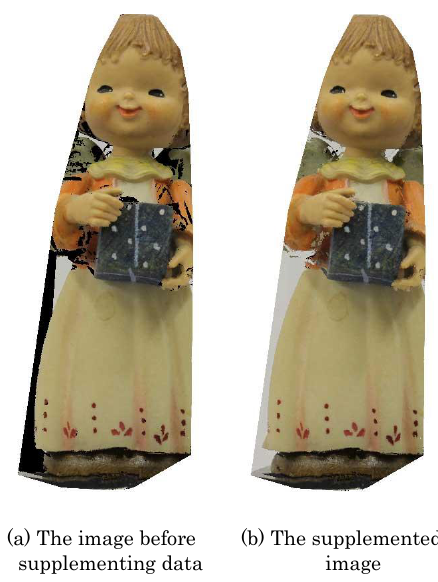
Figure 15. Supplemented difference image.